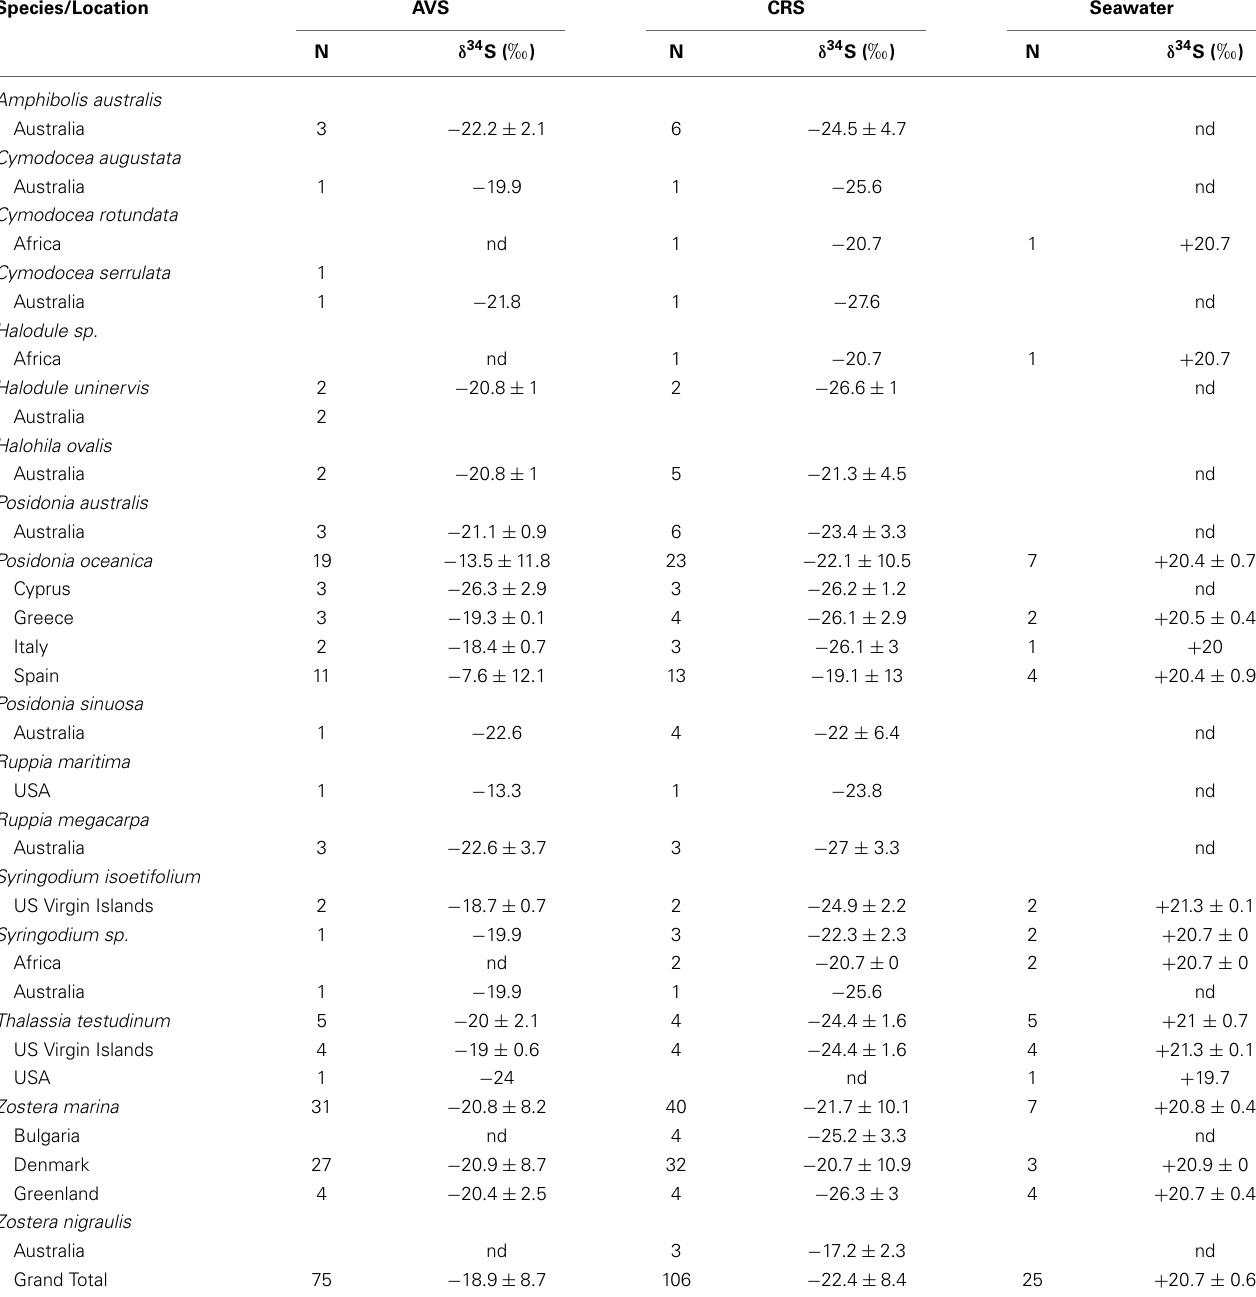
Table 1 | Sulfur sources (sulfate and sulfide) δ 34 S from seagrass meadows represented by acid volatile sulfide (AVS), chromium reducible sulfur (CRS), and seawater sulfate.